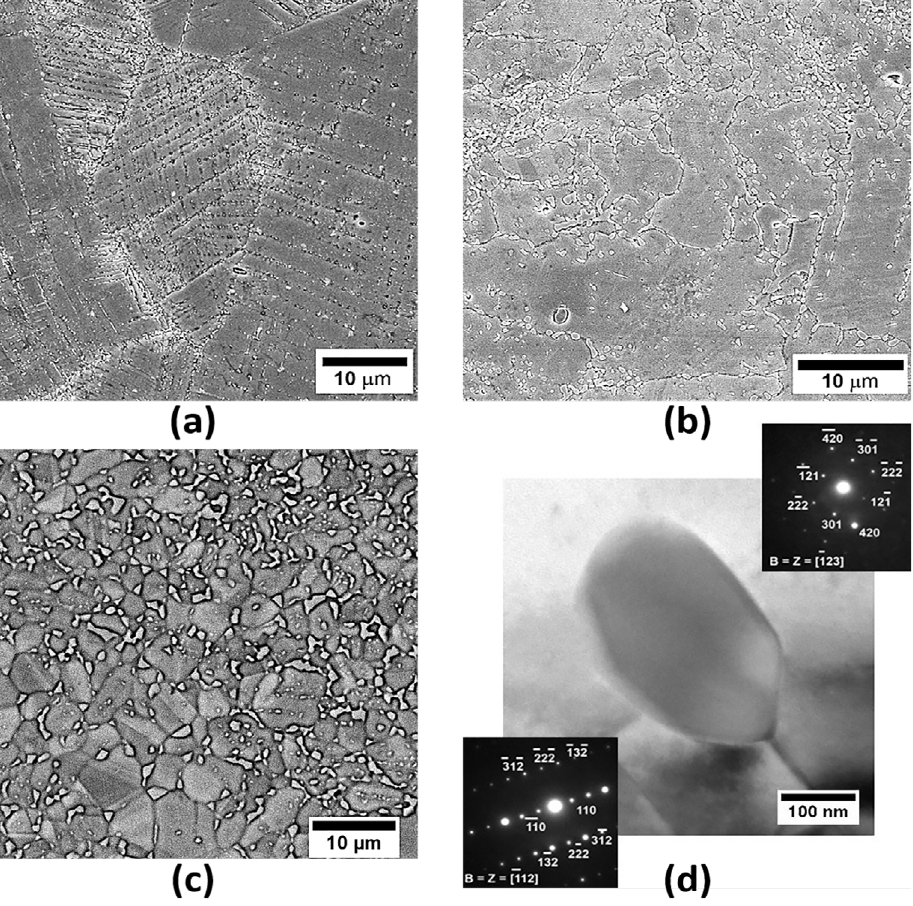
Figure 3. (a) sample ST + 2ECAE + 650ºC (SEM-SE), (b) sample ST + 2ECAE + 750ºC (SEM-SE), (c) sample ST + 2ECAE + 850ºC (SEM-BSE) (d) TEM-BF and SADP of the χ phase particle in the [ 123]